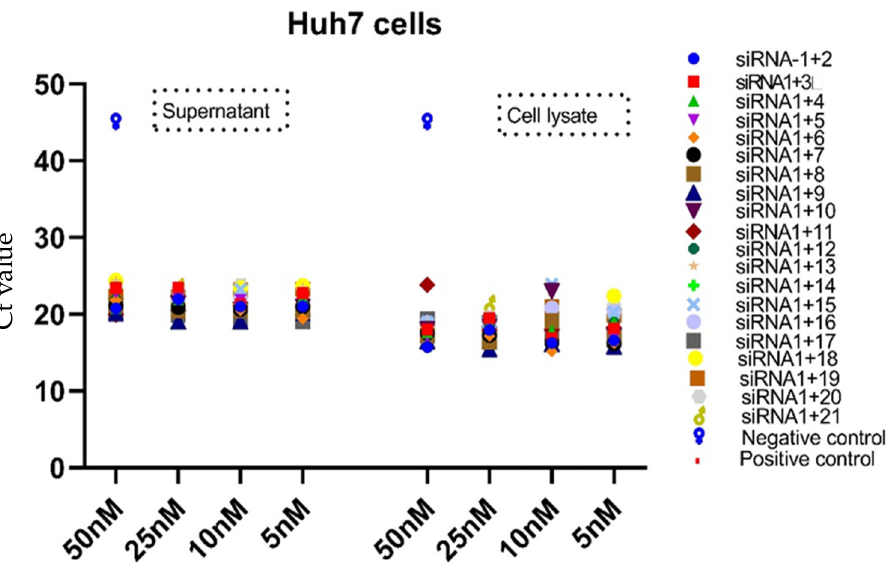
Figure 5. Presentation of Ct values of combined use of siRNAs in both the cell lysate and supernatant